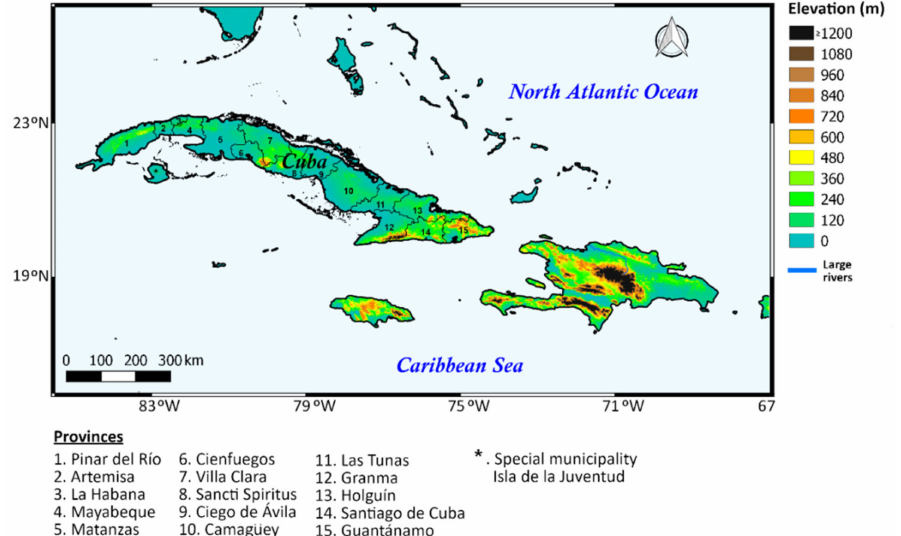
Figure 1. The geographical location of Cuba and its provinces. The elevation is shaded green-brown (in meters above sea level). The data elevation used has been downloaded from the HydroSHEDS project